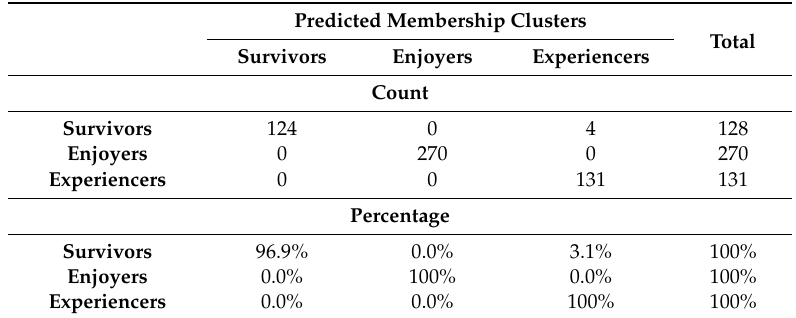
Table 2. Discriminant analysis